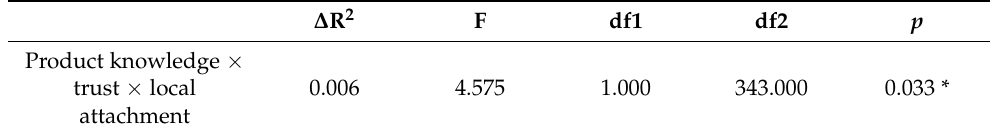
Table 7. Three-way interaction test of the multiplication of local attachment and trust in product knowledge and purchase